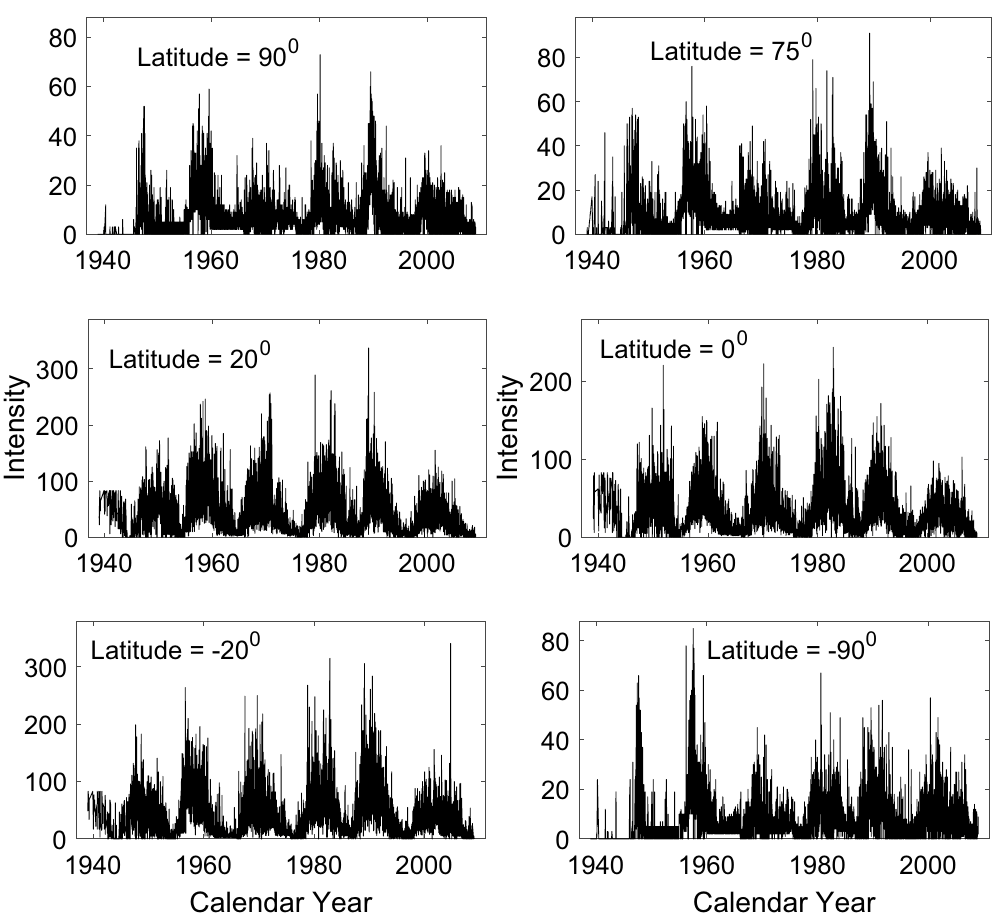
Figure 2. Time series of CI at 6 latitudes. The latitudes are shown at the top of each